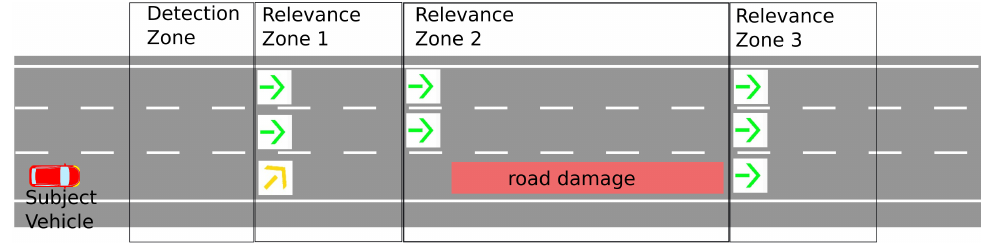
Figure 2. Lane change recommendation scenario description (see Table 1 for the definitions of the pictogram